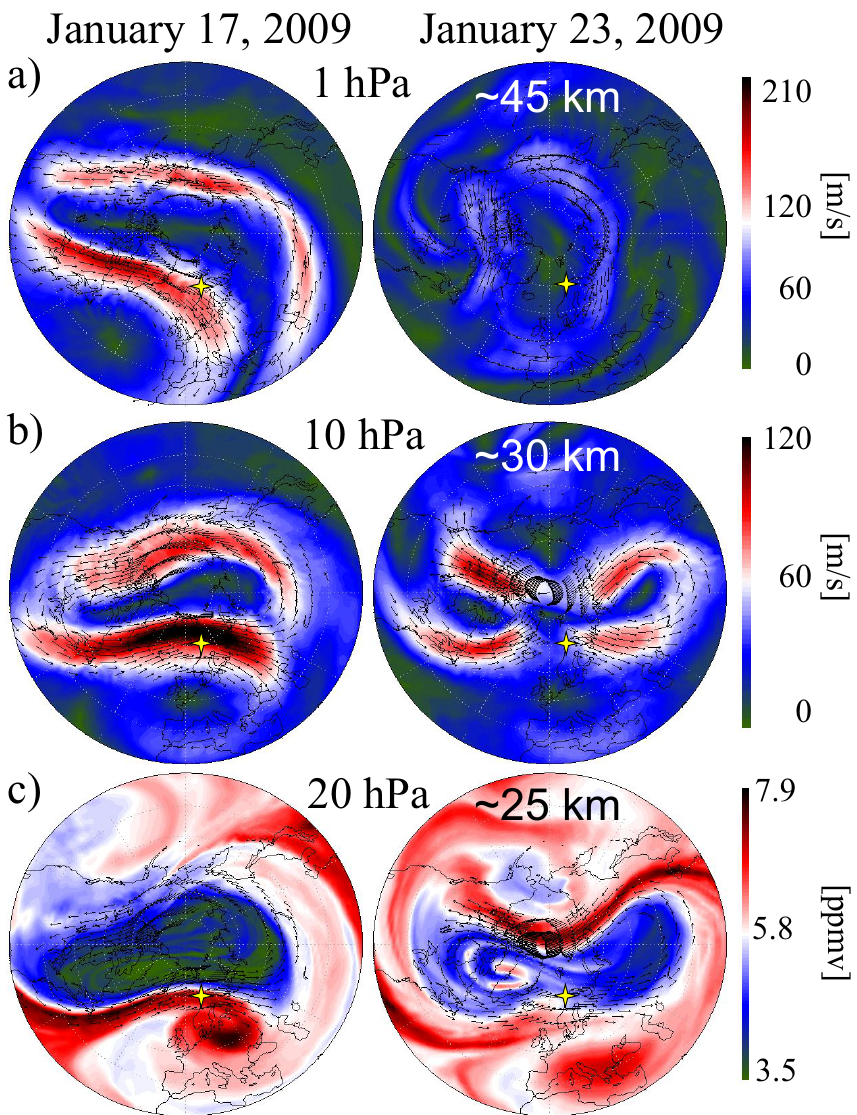
Fig. 11. Horizontal wind and ozone concentration on different levels on 17 January and 23 January 2009 18:00UT extracted from ECMWF (European Center for Medium range Weather Forecast) operational analysis. (a) Horizontal wind at 1hPa level ( ∼ 45km). (b) Horizontal wind at 10hPa level ( ∼ 30km). (c) Ozone (color contour) and horizontal wind (vectors) at 20hPa level ( ∼ 25km). Wind vectors are only plotted for wind speeds larger than 40m/s. Please note that the color scale is changing for the different pressure levels. The location of ALOMAR is indicated by a yellow star. Greenwich Meridian is found at the bottom of the